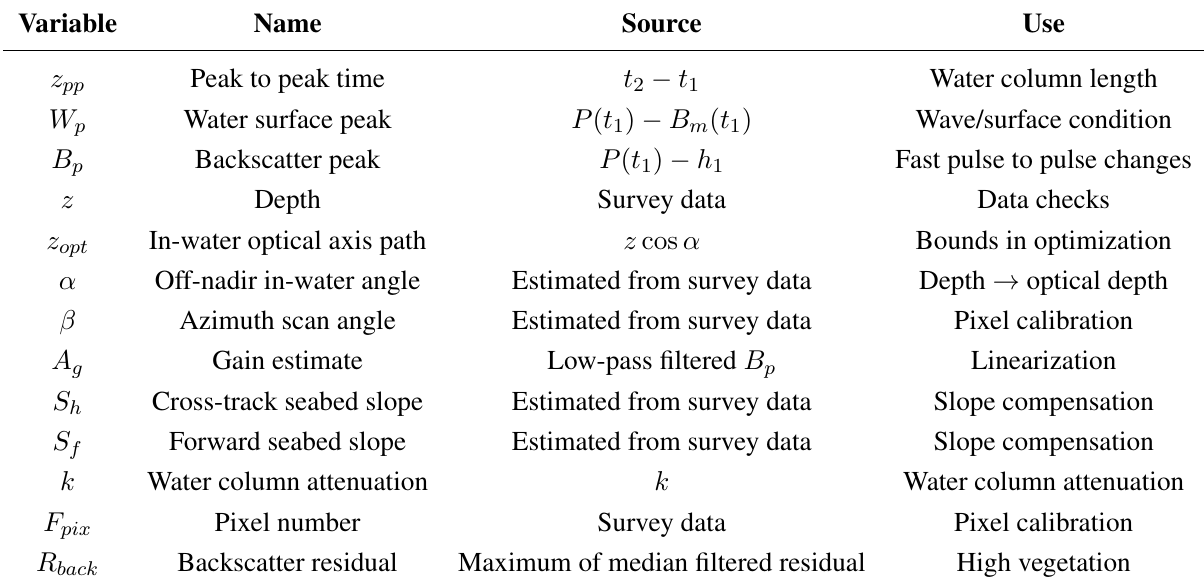
Table 2. List of condition